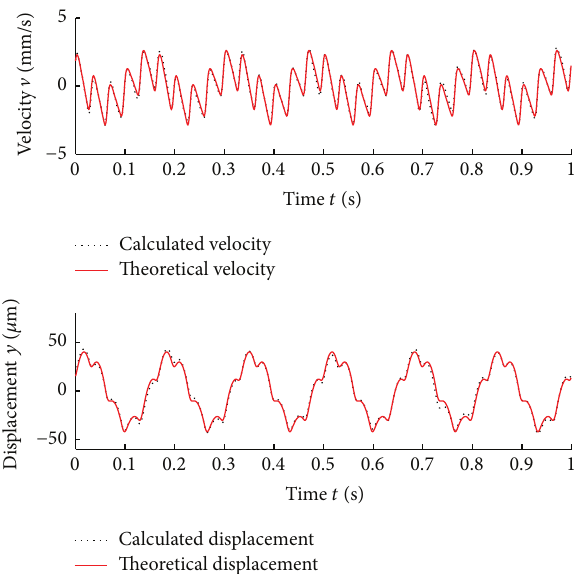
Figure 5: Comparison of FIE-based results with the theoretical